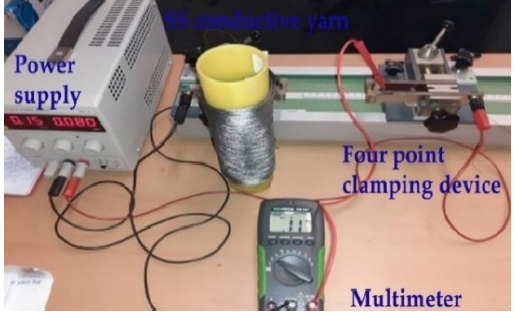
Figure 3. Measuring of length-dependent resistance (four-point clamping device).